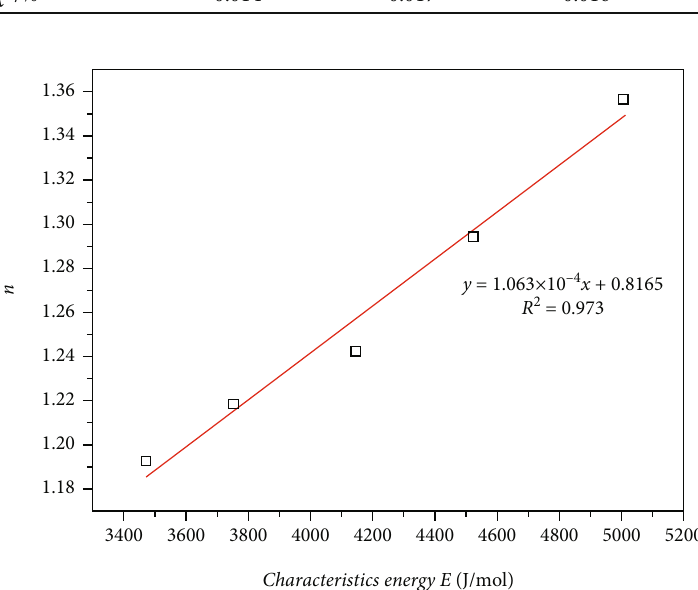
Figure 7: Linear relationship between DA parameter n and E .